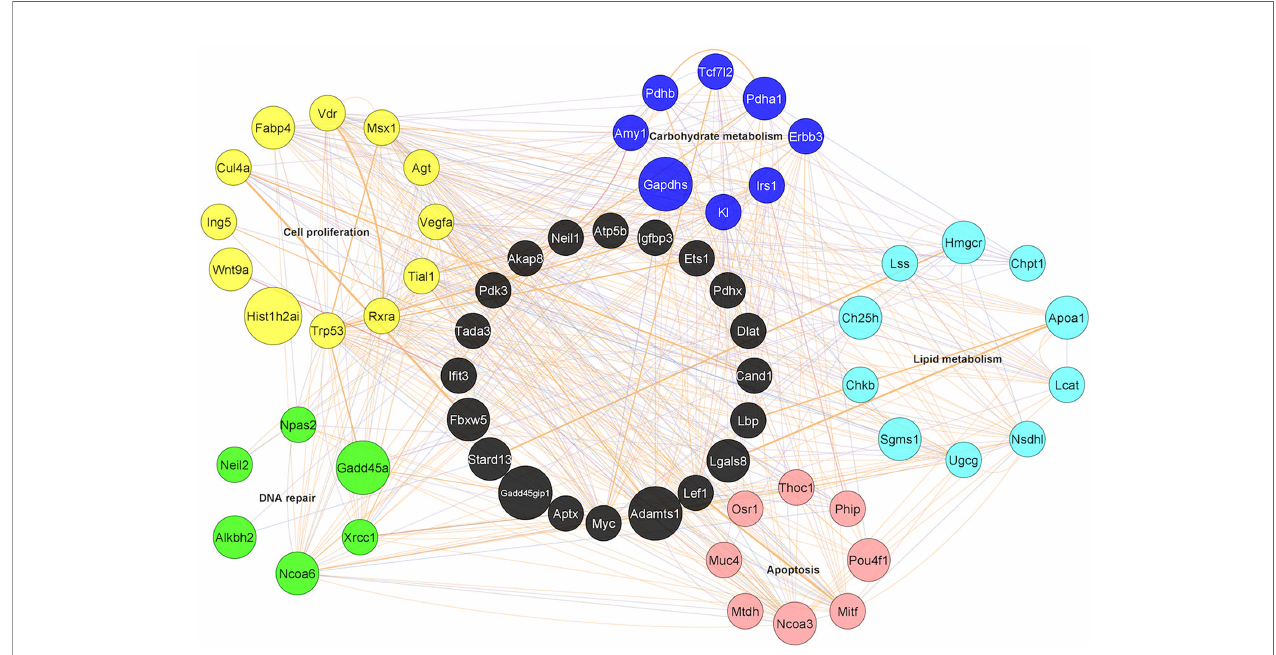
FIGURE 1 | Gene networks in long-lived CD4 memory T cells. Five different gene programs were identi fi ed as dynamically regulated during memory CD4 T cell differentiation. The genes shown were from the long-lived memory CD4 cells 10.5 months post immunization as compared to naïve controls and are marked in different colors: Yellow: cell proliferation; Green: DNA repair; Red: Apoptosis; Light blue: Lipid metabolism; Dark blue: Carbohydrate metabolism; Black: Not identi fi ed in the fi ve gene programs but served as connecting genes. Each line represents an interaction/co-expression of genes as identi fi ed by literature